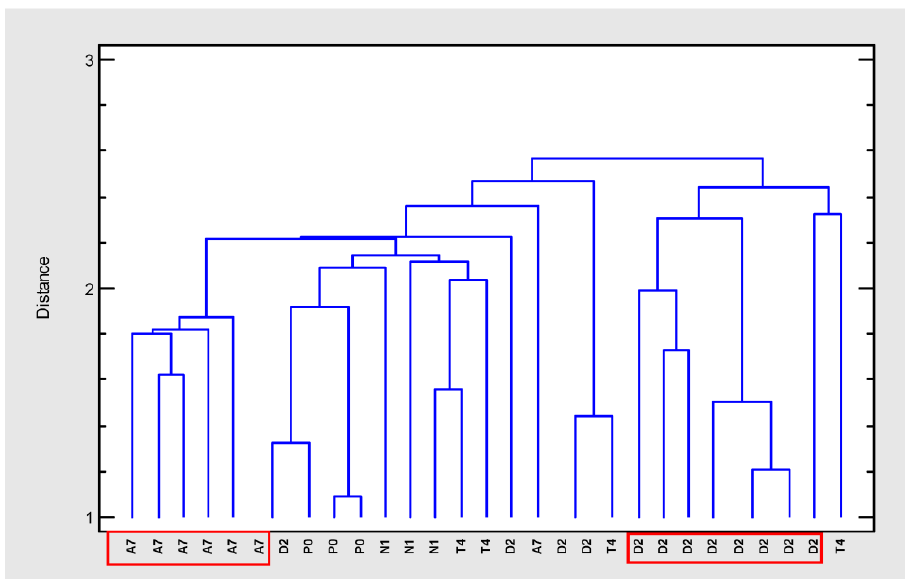
Figure 2. Dendrogram (farthest neighbor method, housing block) generated from cluster analysis of GC – MS data of extracts from five Cannabis sativa varieties (A7, D2, N1, P0, T4).